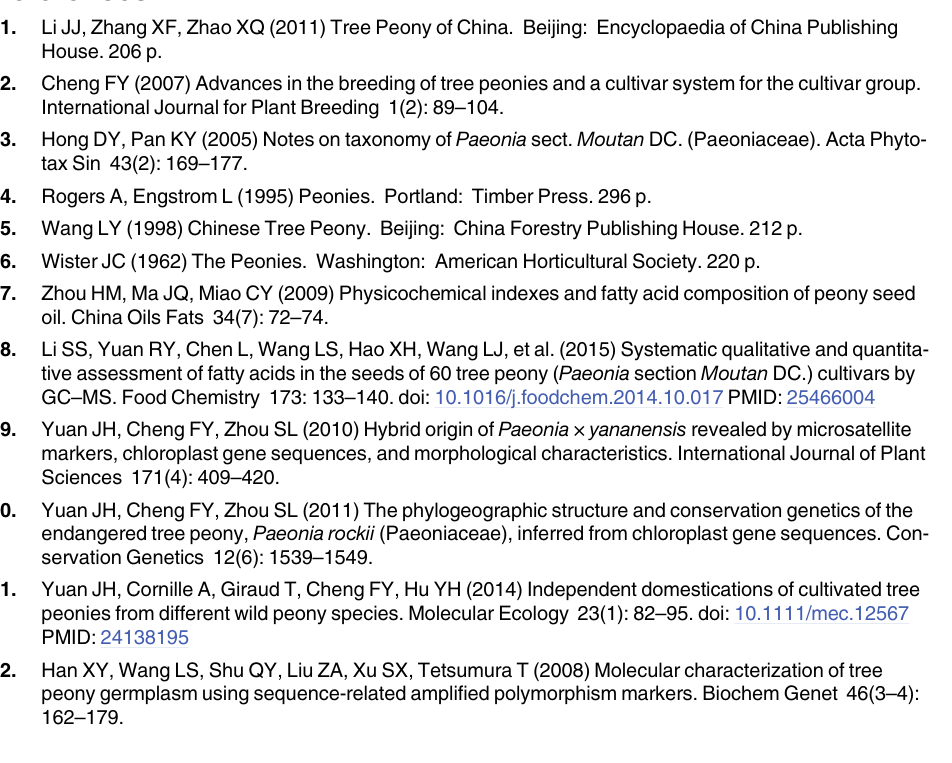
S1 Table. Summary of Specific-locus Amplified Fragment Sequencing data in tree peony mapping population. S2 Table. The sequences of 1189 SLAF markers which were mapped onto the genetic map of tree peony. S3 Table. Details of genetic linkage map of tree peony constructed by HighMap and Join-